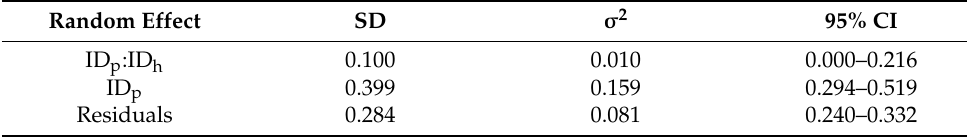
Figure 2. Final model for log(NLR x ) ( A ) Coefficients plot of the final model for log(NLR x ). NLR 1 — neutrophil to lymphocyte ratio value from the first peripheral blood count. NLR 2 —neutrophil to lymphocyte ratio value from the last peripheral blood count. ( B ) Visualization of the final model for log(NLR x ). The squares represent the predicted mean values for each group. 95% confidence intervals were also marked. The colors represent the status of taking antipsychotic drugs during the 1 month prior to admission. Points are individual cases where a shift has been applied for overlapping points. Table 4. Summary of the random effects of the final model for log(NLR x